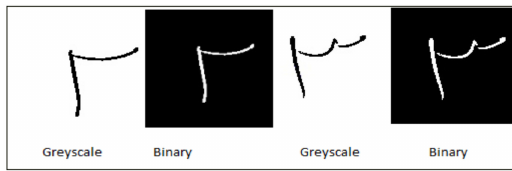
Figure 8. Grayscale vs. binary. The values of the image matrix that were between 0 and 255 were converted to double precision values because the convolutional neural network performs better when input values are normalized. The image is actually a matrix of numbers as shown in Figure 9.